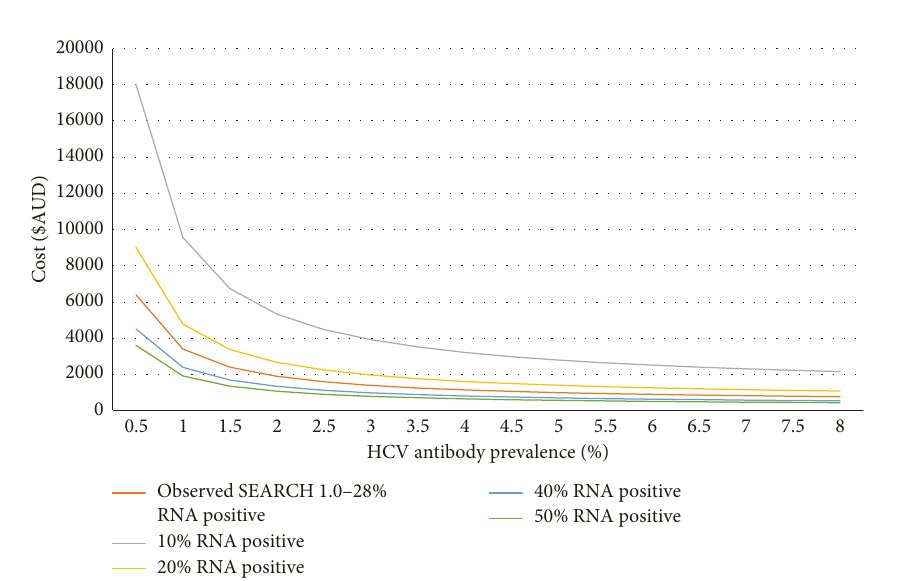
Figure 3: SEARCH 2 estimated cost per RNA-positive patient detected according to HCV antibody prevalence ( x axis) and the proportion of patients RNA-positive. Table 3: Cost (AUD$) per patient RNA-positive patient detected under several scenarios and variable HCV antibody prevalence. HCV antibody prevalence (%) 10% RNA-positive